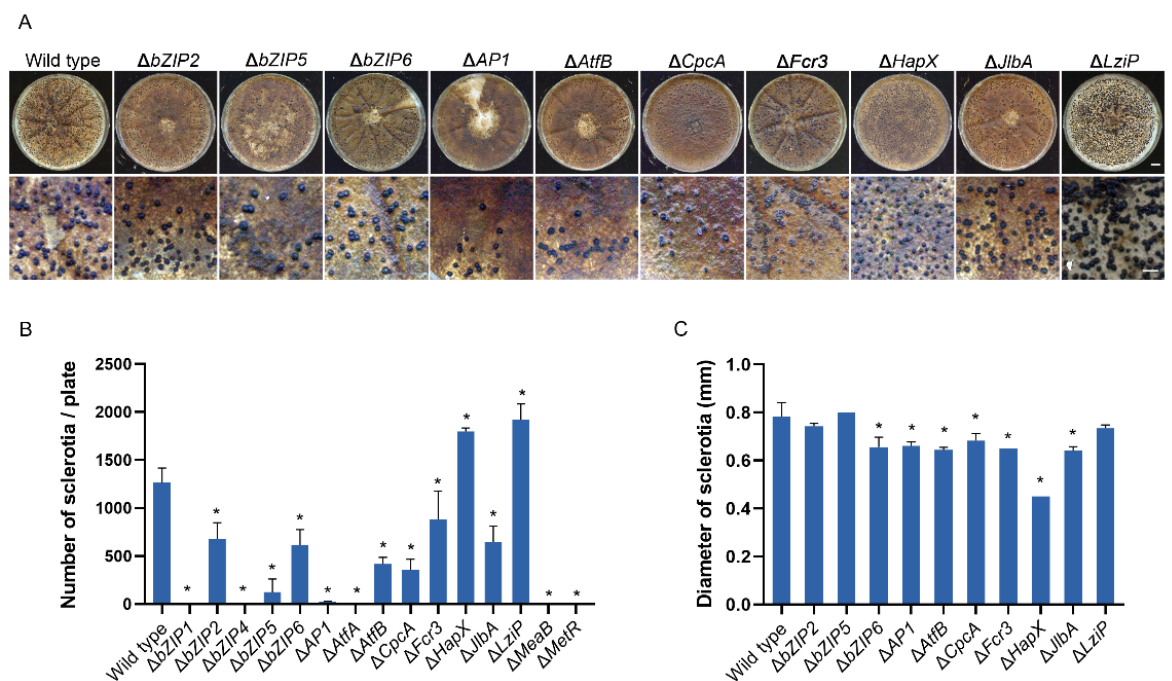
Figure 6. Analysis of the sclerotial production of Aspergillus flavus strains. ( A ) Colonies of mutants with sclerotia. In total, 1 × 10 4 spores were cultured on 90 mm WKM plates in the dark for 10 days at 30 °C. Bar = 1 cm. ( B ) The number of sclerotia per plate. Bar = 2 mm. ( C ) Analyses of the size of sclerotia. Ten sclerotia were arranged in a row, and the length was measured and then converted into the diameter (mm) of a sclerotium. Error bars represent the SD. * p < 0.05, significant difference from the wild-type group as estimated using a Dunnett test. SD, standard deviation; WKM, Wickerham